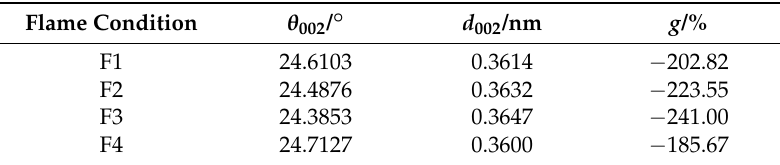
Table 3. The graphitization degree the under different